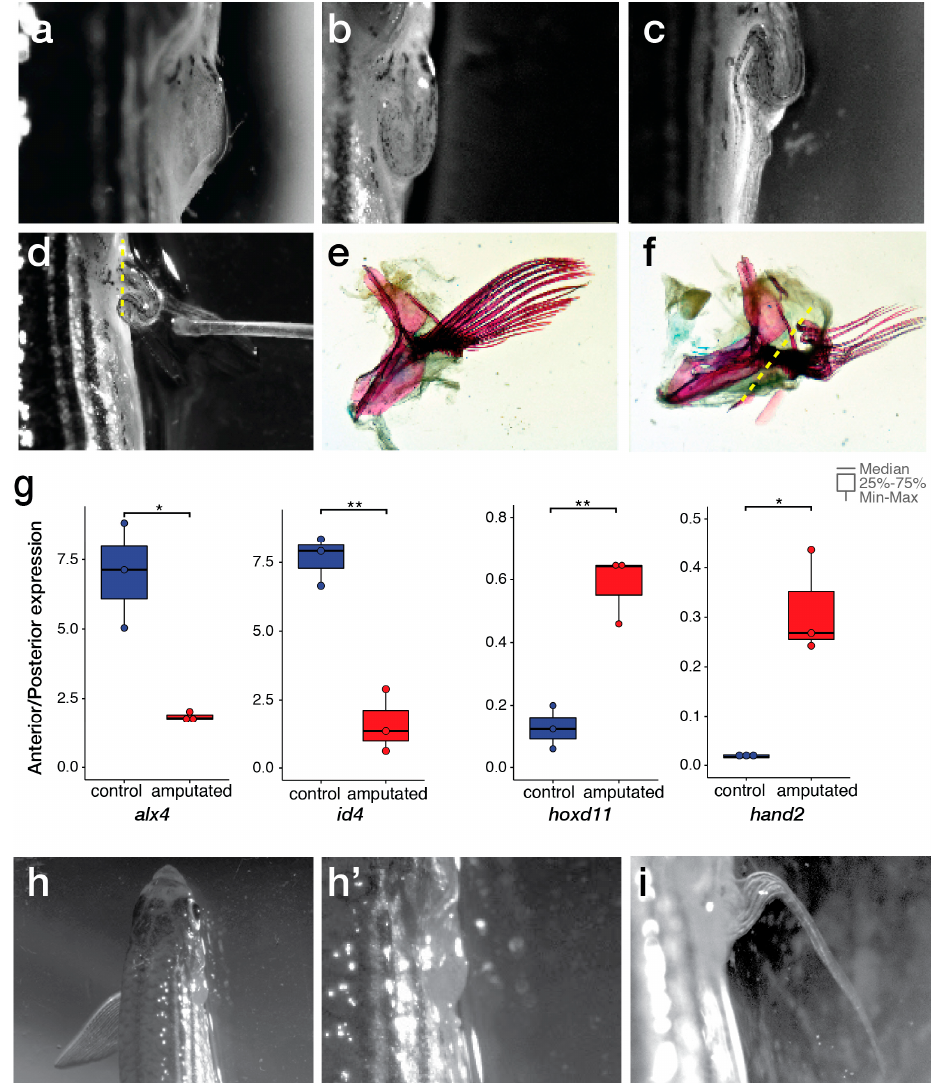
Figure 2. Endoskeletal regeneration of zebrafish. ( a ) Blastemal tissue one week post amputation (wpa), dorsal view. ( b ) Small heteromorphic fin stump at 2 wpa, dorsal view. ( c ) Regenerated pectoral fin stump at 3 wpa, dorsal view. ( d ) Regenerated pectoral fin at 6 wpa, dorsal view. ( e , f ) Alcian Blue and Alizarin Red stainings of control and 6 wpa regenerated fins (Yellow dashed lines denote the approximate site of the original amputation). ( g ) Relative (anterior/posterior) gene expression of alx4 , id4 , hand2 and hoxd11 in control and regenerated fins suggest that AP patterning is impaired in regenerates (*: p < 0.05; **: p < 0.01). ( h , h’ ) Lack of regeneration after second endoskeletal amputation (n = 2). ( i ) Regenerated fin piece after a second endoskeletal amputation.